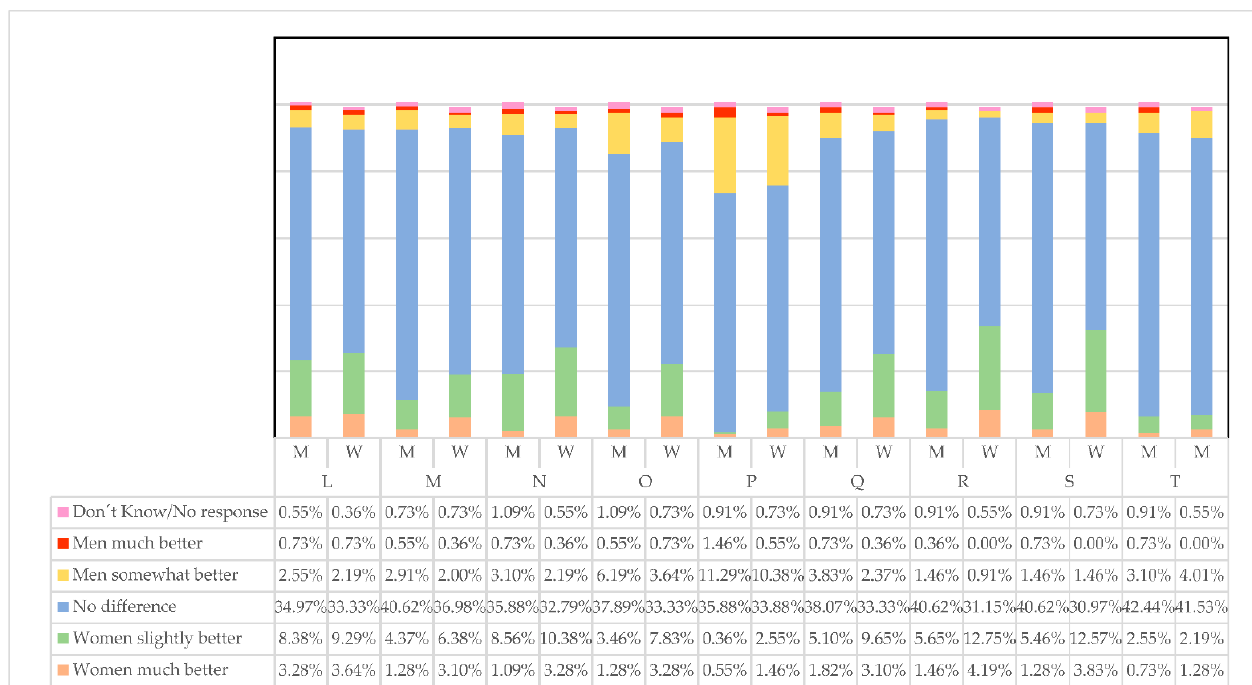
Figure 1. Qualities required to be an efficient leader. Source: Own elaboration.